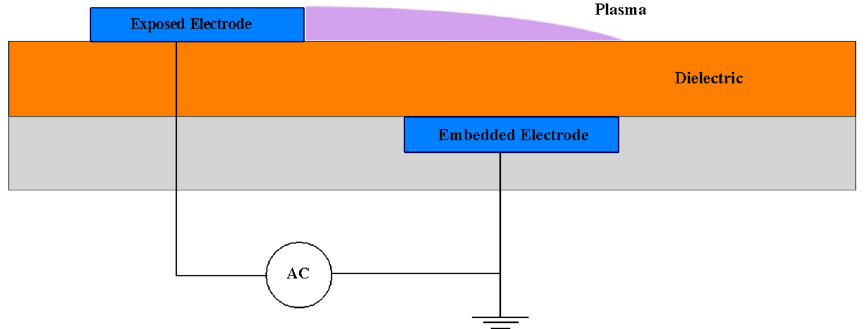
Figure 1. DBD plasma actuator